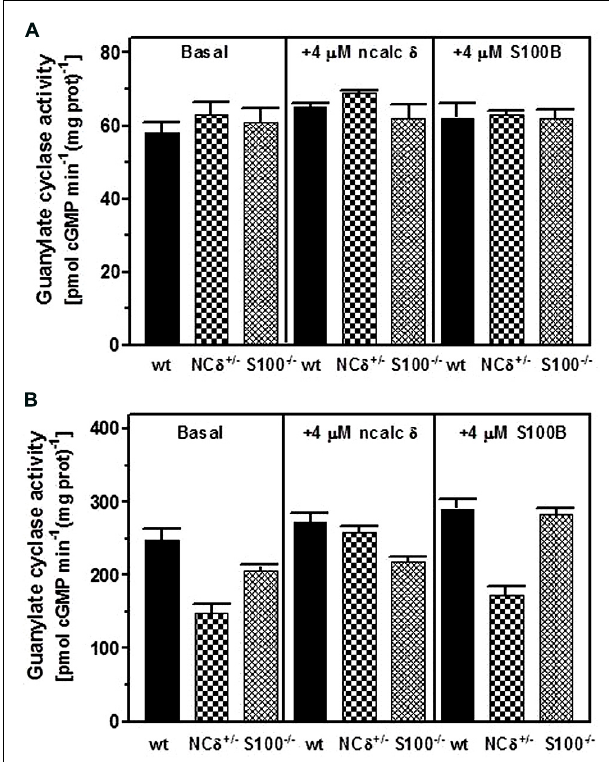
FIGURE 6 | Comparison of NC δ and S100B stimulatory effects on ROS-GC1 activity in mouse testes. Testes were removed from the wild type (WT), NC δ + / − , and S100 − / − mice and their particulate fractions were isolated in the presence of 100 μ M Ca 2 + . (A) The membranes were assayed for guanylate cyclase activity in the presence of 1 mM EGTA in the absence (panel “basal”) or presence of 4 μ M myristoylated NC δ (panel (“ + 4 μ M ncalc δ ”) or 4 μ M S100B (panel “ + S100B”). (B) The membranes were assayed for guanylate cyclase activity in the presence of 10 μ M Ca 2 + (“basal”) or with the addition of 4 μ M NC δ (panel “ + 4 μ M ncalc δ ”) or 4 μ M S100B (panel “ + 4 μ M S100B”).The experiment was done in triplicate and repeated with separate membrane preparations.The results are mean ± SD of these